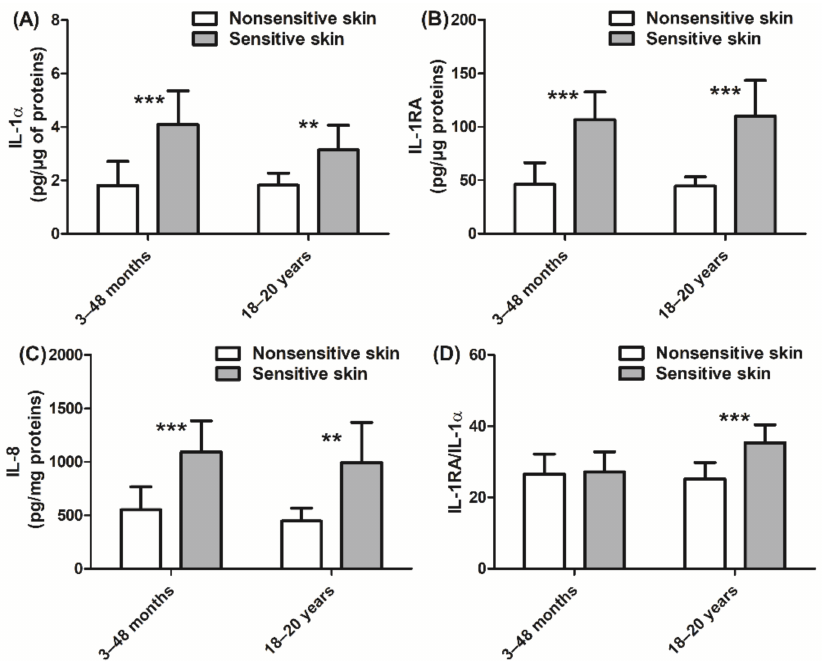
Figure 4. Quantification of cytokines: ( A ) IL-1 α ; ( B ) IL-1RA; ( C ) IL-8; ( D ) IL-1RA/IL-1 α ratio. Data are shown as the mean ± SD of all subjects in the group. ** p < 0.01, *** p <